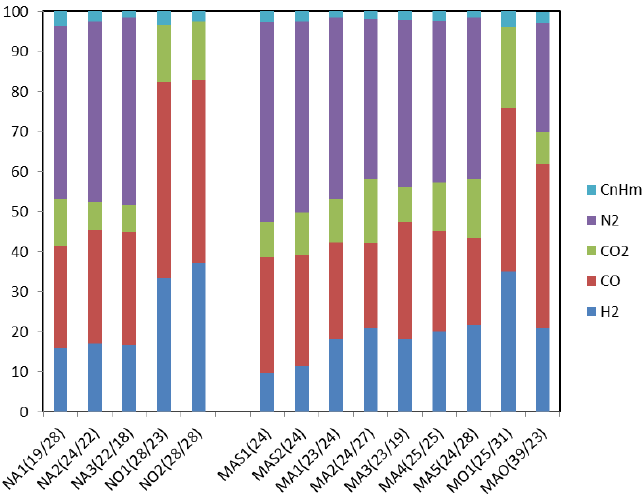
Figure 6. Composition of clean syngas (C n H m is the sum of CH 4 , C 2 H 6 , C 3 H 8 ).